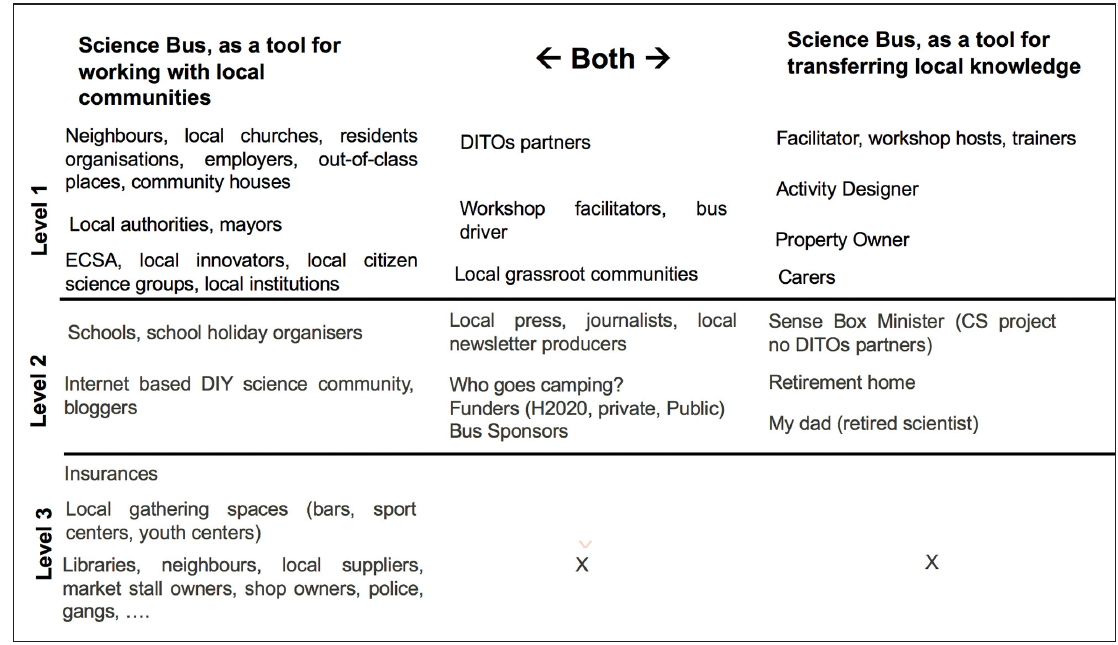
Figure 2: The Science Bus stakeholder mapping. Three categories of stakeholders include those who are simply engaged in the project (i.e., “Science Bus as a Tool for working with local communities” column), those who develop skills and through their participation contribute to expanding the knowledge of participants (“Science Bus as a tool for transferring local knowledge” column), and those who do both (middle column). Levels 1, 2, and 3 correspond to levels of importance; level 1 stakeholders are essential for the project, level 2 are important, and level 3 are the least important. For example, local grassroot communities can be involved in ways that support the Science Bus activities in order to engage with local communities by advertising its activities to their members. They also may be involved to organise or participate in the organisation of Science Bus activities to better communicate and capture local issues. They are considered to be essential for the successful implementation of the Science Bus